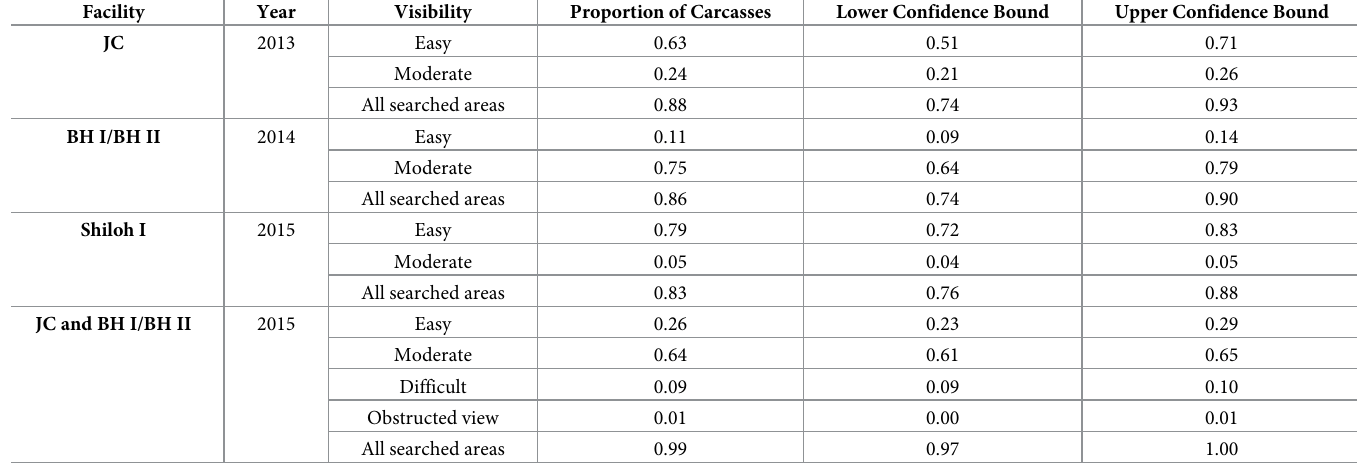
a Confidence bounds are for a 90% confidence interval.